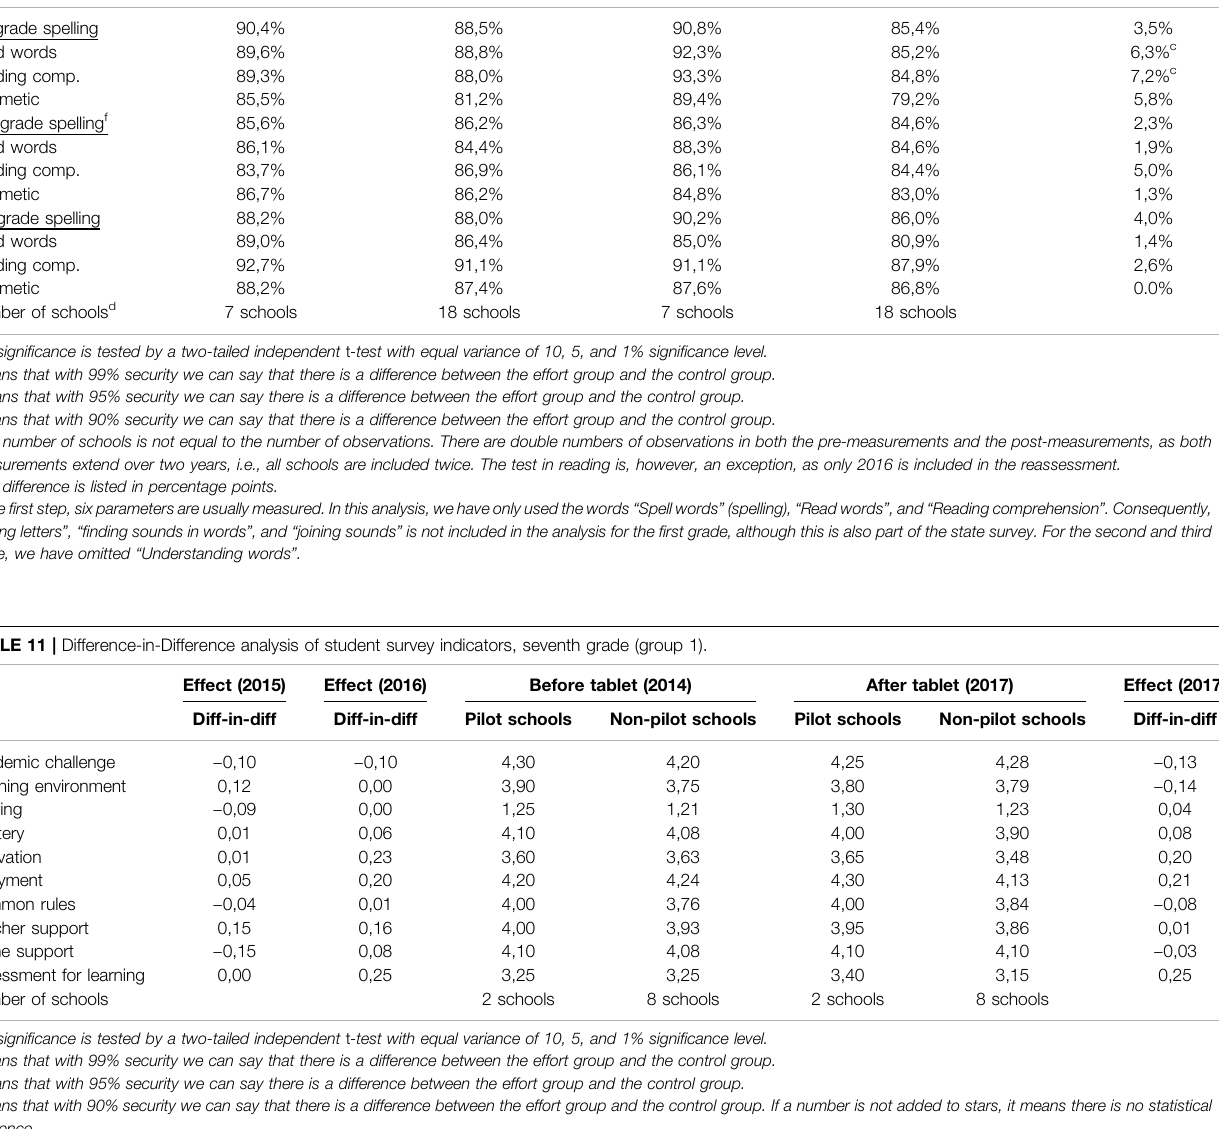
(cid:129) Table 5 shows the average test results for national tests in arithmetic and reading for all children, boys and girls, in ninth grade for pilot 1 schools and other schools. The column on the right shows whether pilot 1 schools have developed more